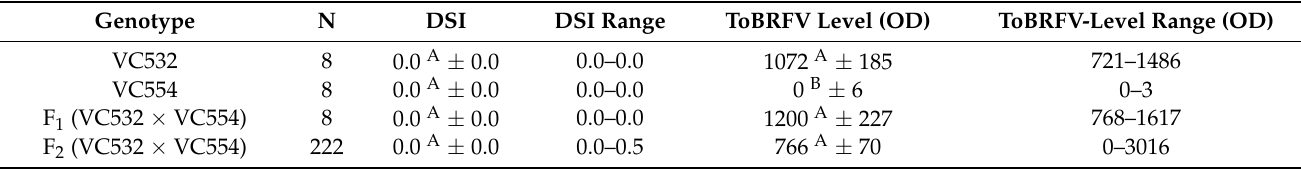
Table 4. Allelic test between the tolerant genotype VC532 and the resistant genotype VC554.